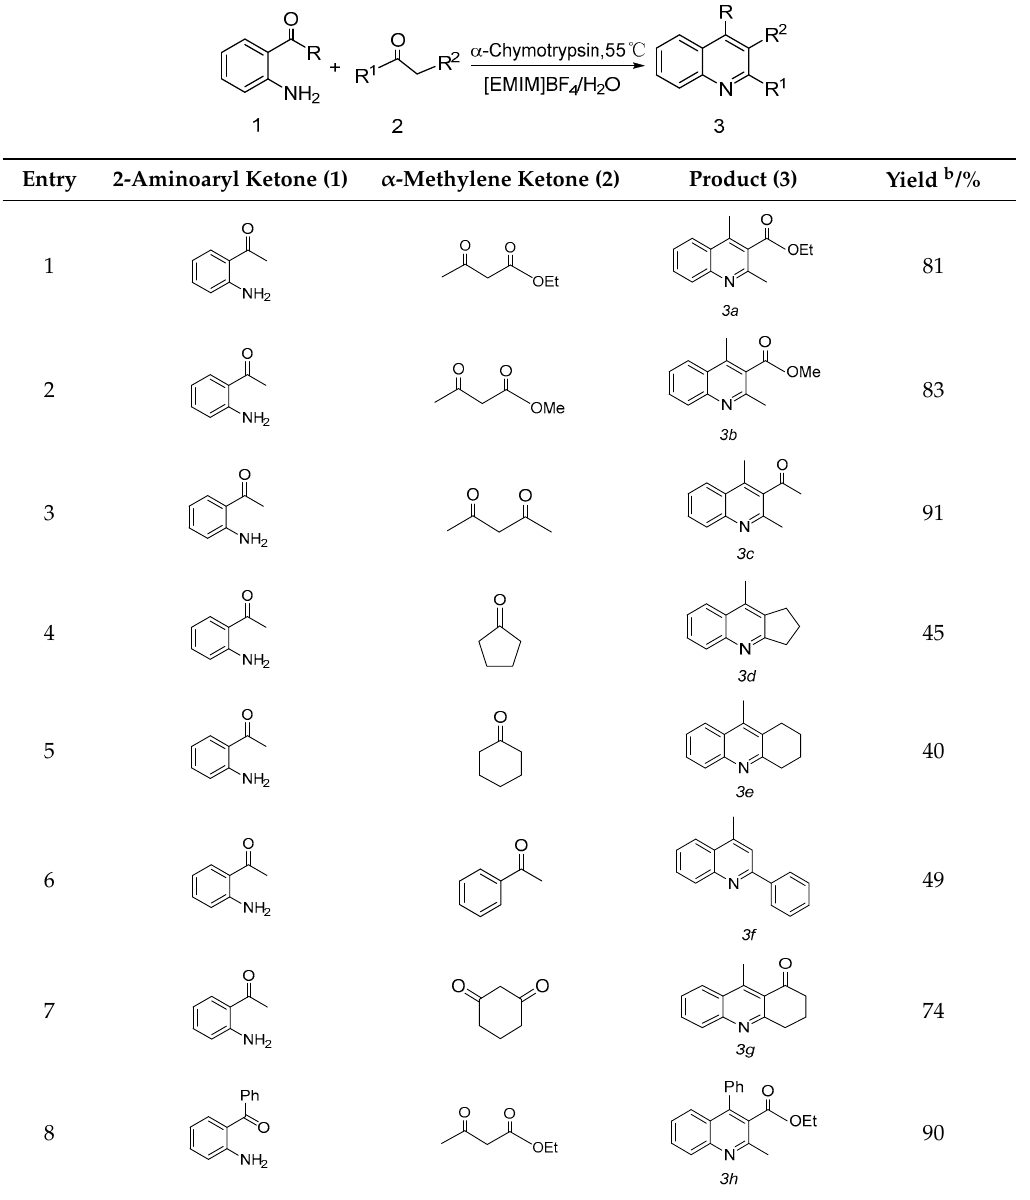
Figure 4. Reaction yields at different enzyme loadings a . a Reaction conditions: 2-aminoacetophenone (0.3 mmol), ethyl acetoacetate (0.36 mmol), and α -chymotrypsin (0, 1, 2, 3, 5, 10, 15, 20 mg/mL) in 20% ([EMIM][BF 4 ]/(H 2 O + [EMIM][BF 4 ]), v / v ) IL aqueous solution at 55 °C for 24 h. b Isolated yield after column chromatography. Table 1. Substrate scope of α -chymotrypsin-catalyzed Friedländer condensation in an IL aqueous solution a .